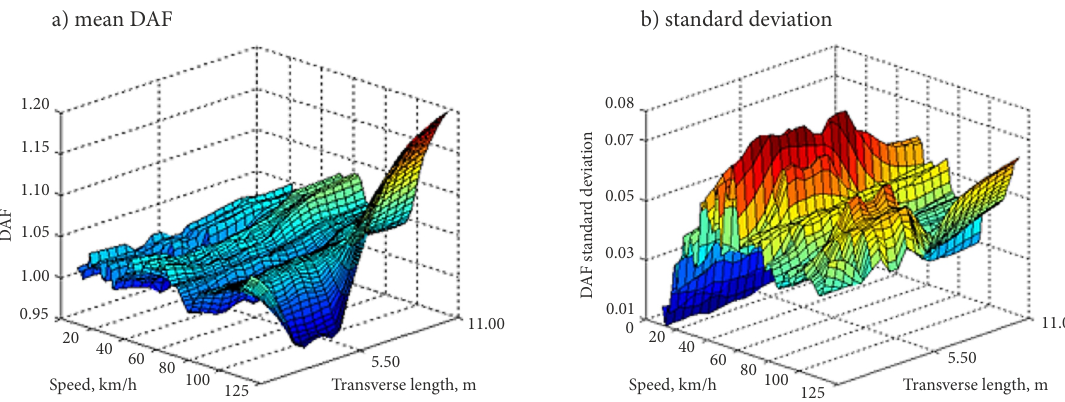
Figure 12. DAF-speed for plate model due to the 5-axle truck on class A profile